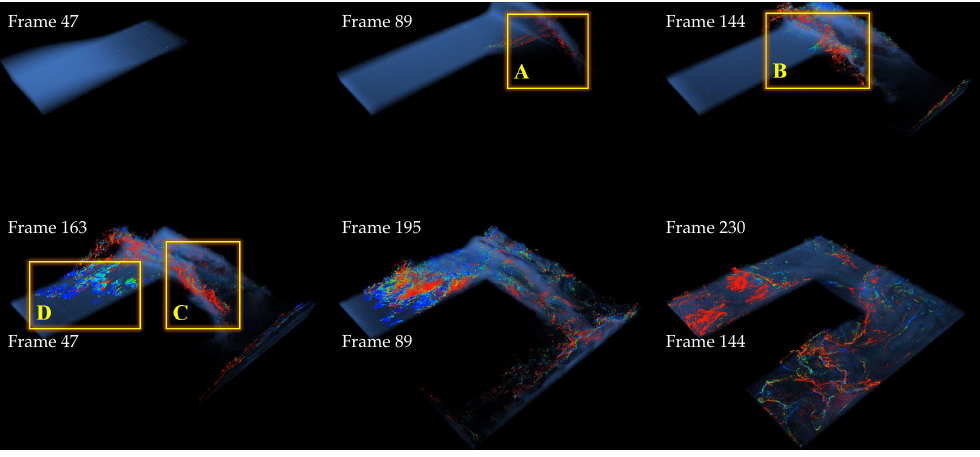
Figure 14. Foam effects by fluid–solid interaction using our method as the water flows along the U- shaped corridor (blue: no angular momentum, green to red: stronger angular momentum). The related video has been submitted as Supplementary Material.